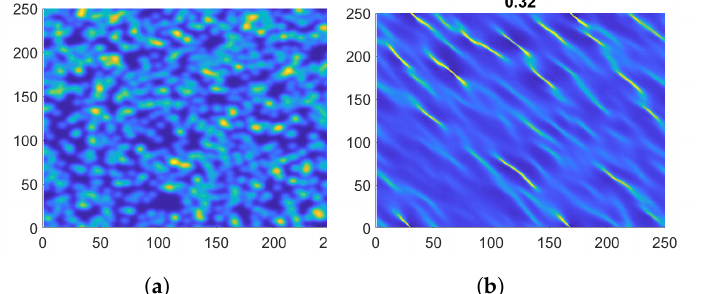
Figure 5. Velocity mixing. ( a ) Initial condition with cell density of 200 cells/mm 2 . ( b ) Solution at 0.32